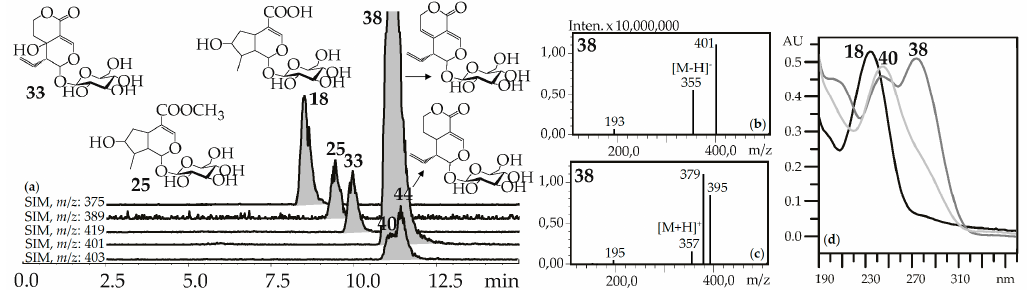
Figure 2. ( a ) HPLC-ESI-MS chromatogram of G. septemfida root extract in SIM-mode { m / z 375 for loganic acid ( 18 ), m / z 389 for loganin ( 25 ), m / z 419 for swertiamarin ( 33 ), m / z 401 for gentiopicroside ( 38 ), m / z 403 for sweroside ( 40; isomeric 44 )}. ( b , c ) Mass spectra of compound 38 in negative and positive ionization mode. ( d ) UV spectra of compounds 18 , 38 and 40 .